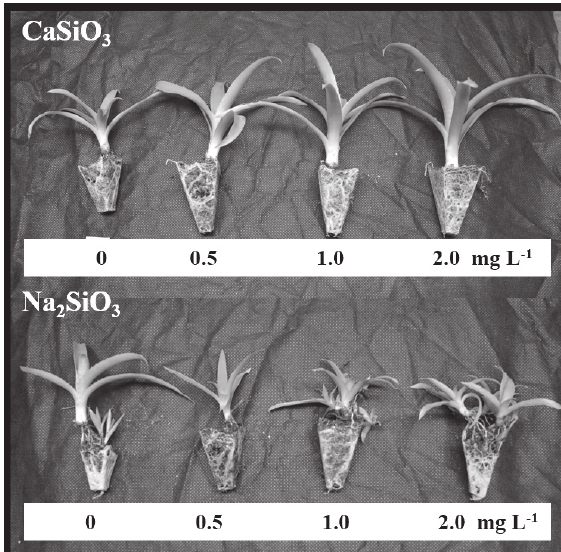
Figure 6 - B. zebrina plants after 60 days of ex vitro growth (acclimatization) in response to sources and concentrations (mg L -1 ) of silicates during the in vitro